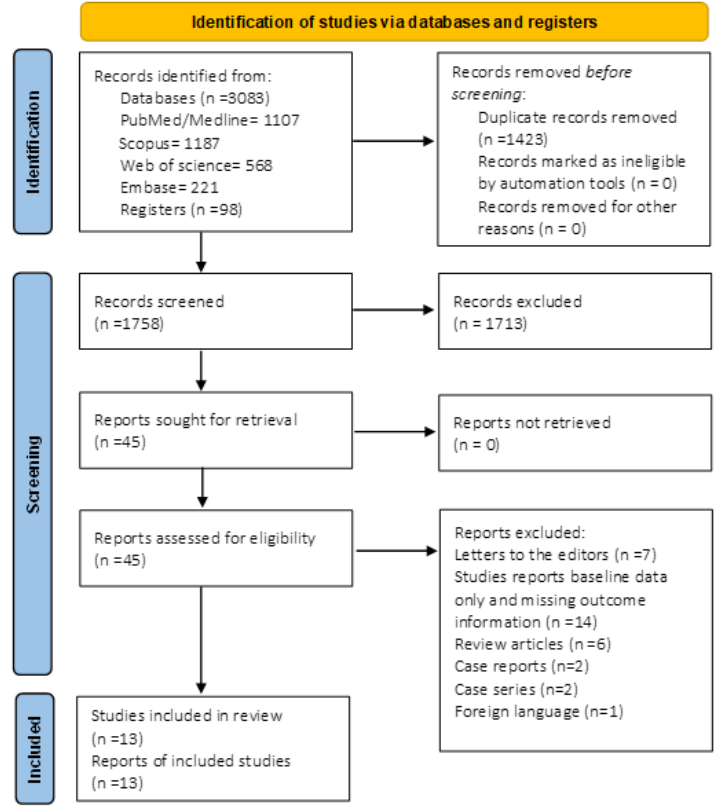
Figure 1. Prisma flow diagram for search and selection process of meta-analysis.